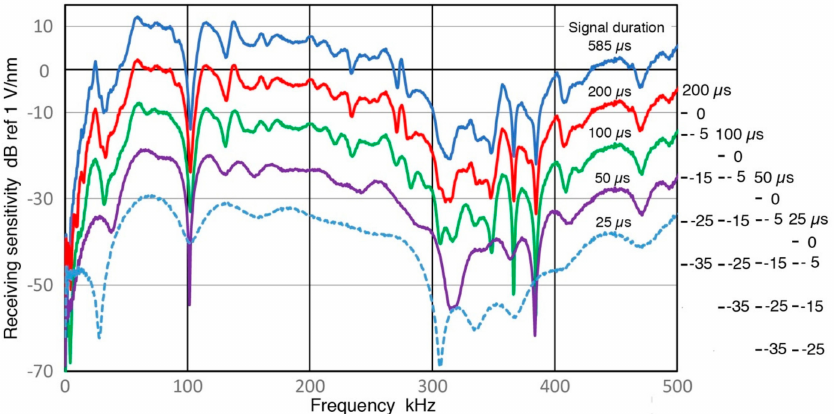
Figure 17. Receiving sensitivity spectra of MA-Bls 40 using different signal length of the waveform in Figure 16. Signal lengths used were 585, 200, 100, 50 and 25 µ s. The results are in blue, red, green, purple and blue dot curves in decreasing order of signal length. Each spectrum is shifted by 10 dB vertically and shifted scales shown at right.